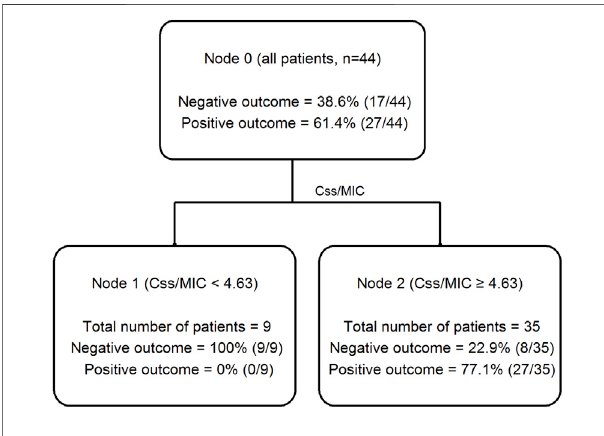
FIGURE 2 | Classi fi cation and regression tree (CART) analysis of the partition of clinical outcome depending on meropenem Css/MIC ratio in critically ill patients ( n (cid:1)